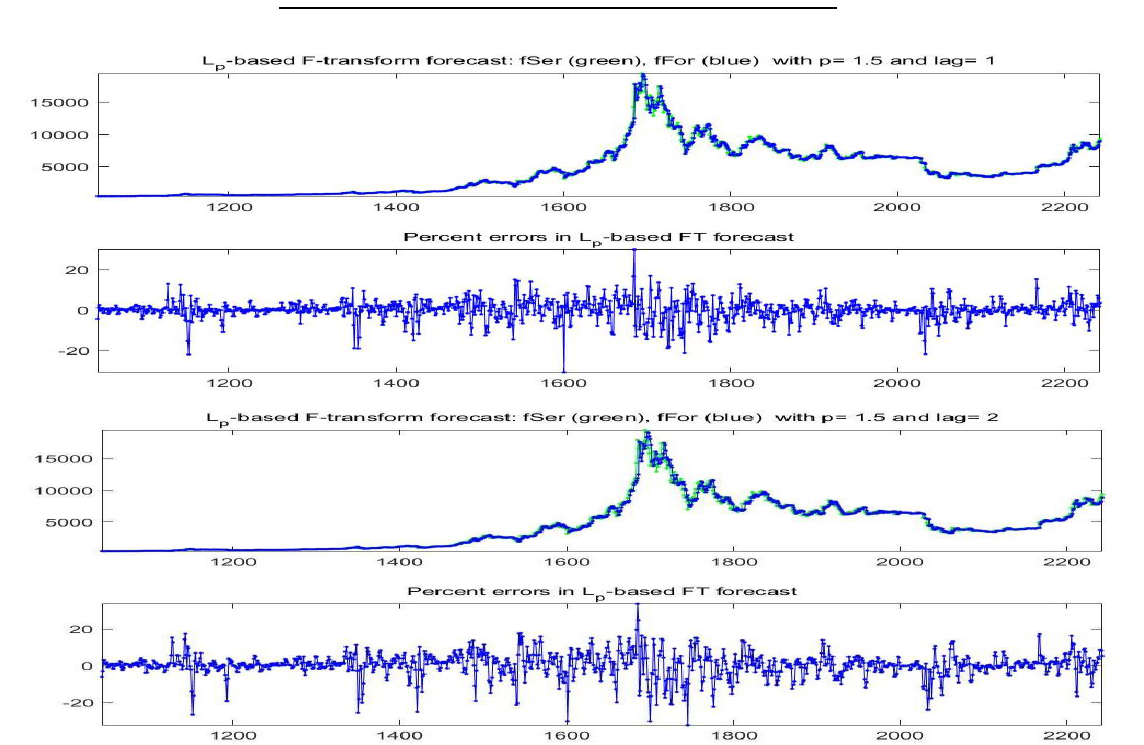
Figure 30. Model A: L p -norm F-transform forecast (denoted as fFor) for the last 1200 days of available data for Bitcoin series (observed time series is denoted as fSer). Here, p = 1.5, q = 1 and two lags l = 1 ( top two pictures), l = 2 ( bottom ). The percent errors 100 fSer t